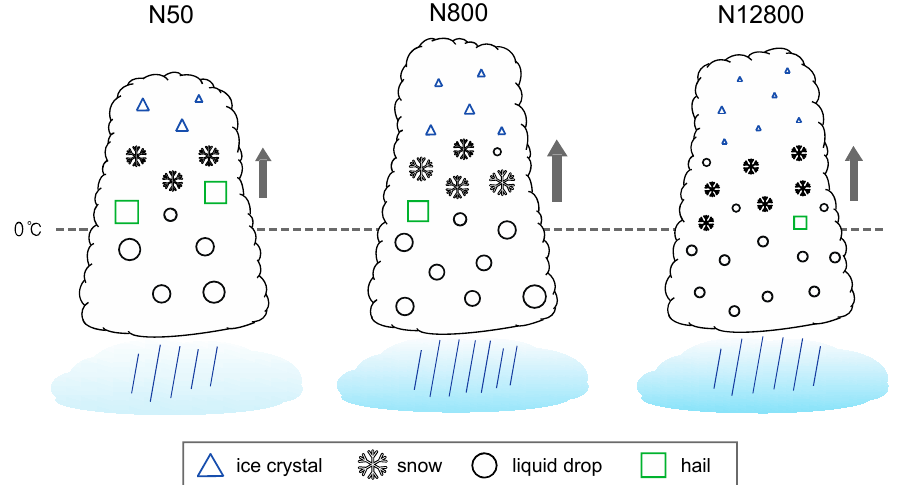
Figure 17. Schematic diagram that depicts the changes in cloud microphysics and dynamics due to different aerosol loadings.